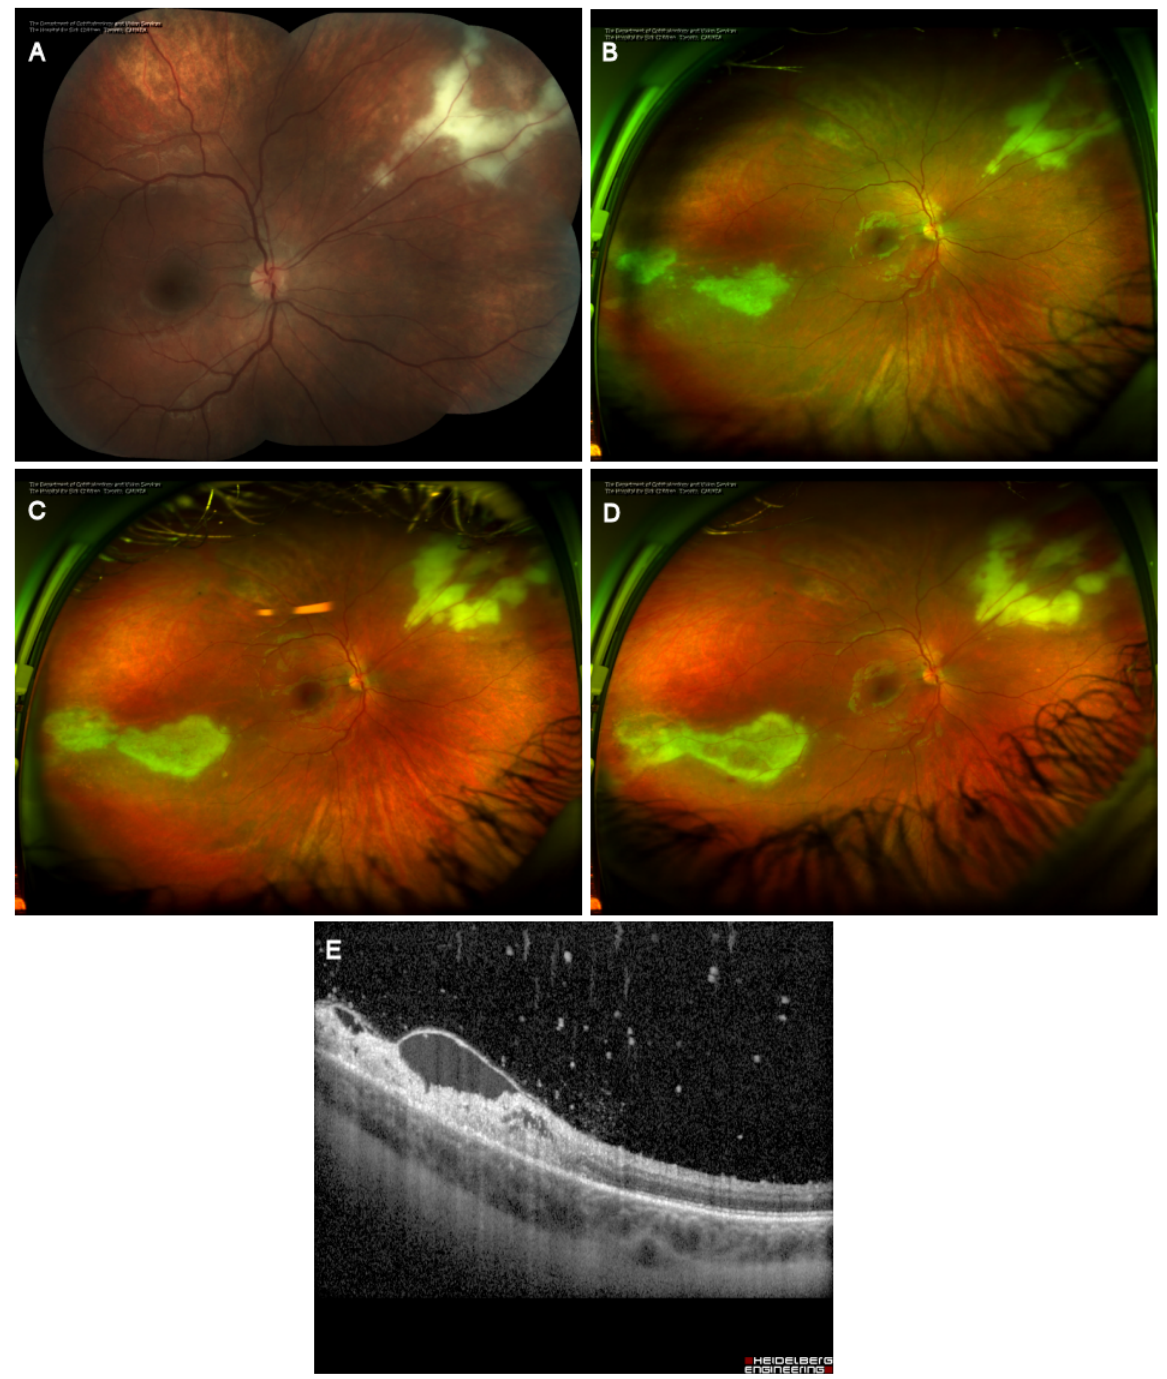
Figure 2: Initial presentation. (A) Color fundus montage photography of the posterior retina of the right eye. Note the white granular retinal lesion. (B) Optos ultra-widefield photography of the right fundus one weeks after the initial presentation demonstrating both supranasal and infratemporal areas of retinitis. (C) Ultra-widefield photography of the right fundus two weeks after the initial presentation demonstrating progression of the lesions despite systemic antivirals. (D) Further progression three weeks after initial presentation. (E) OCT over the edge of the infratemporal area of retinitis demonstrating focal vitritis, intraretinal fluid and retinal